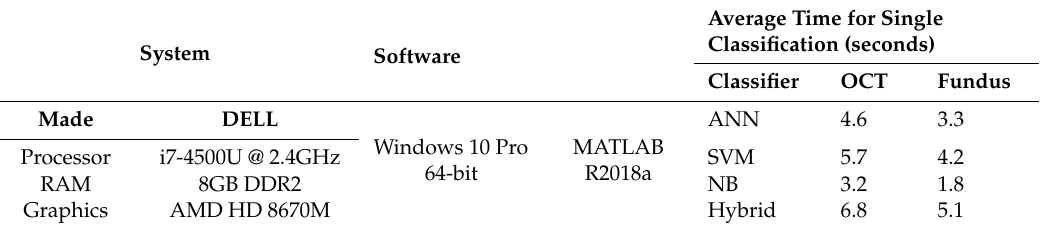
Table 10. Details of the system and software used for conducting this